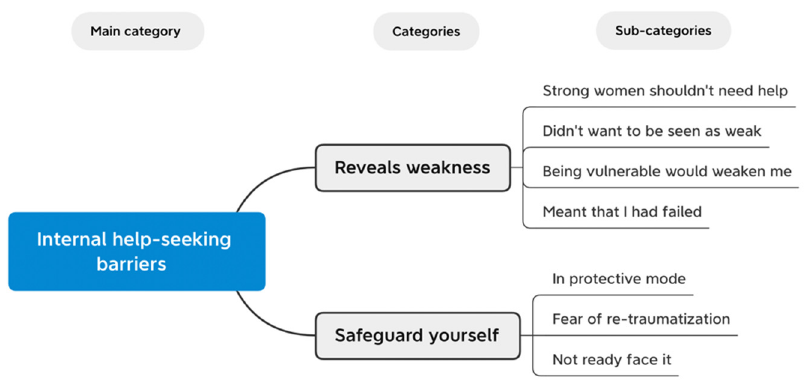
Figure 1. Conceptual diagram of the newly identified help-seeking barriers.